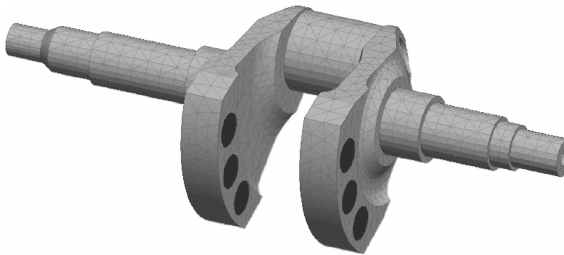
Figure 3: FE model of the crankshaft with 3D elements (the dark elements represent the balancing